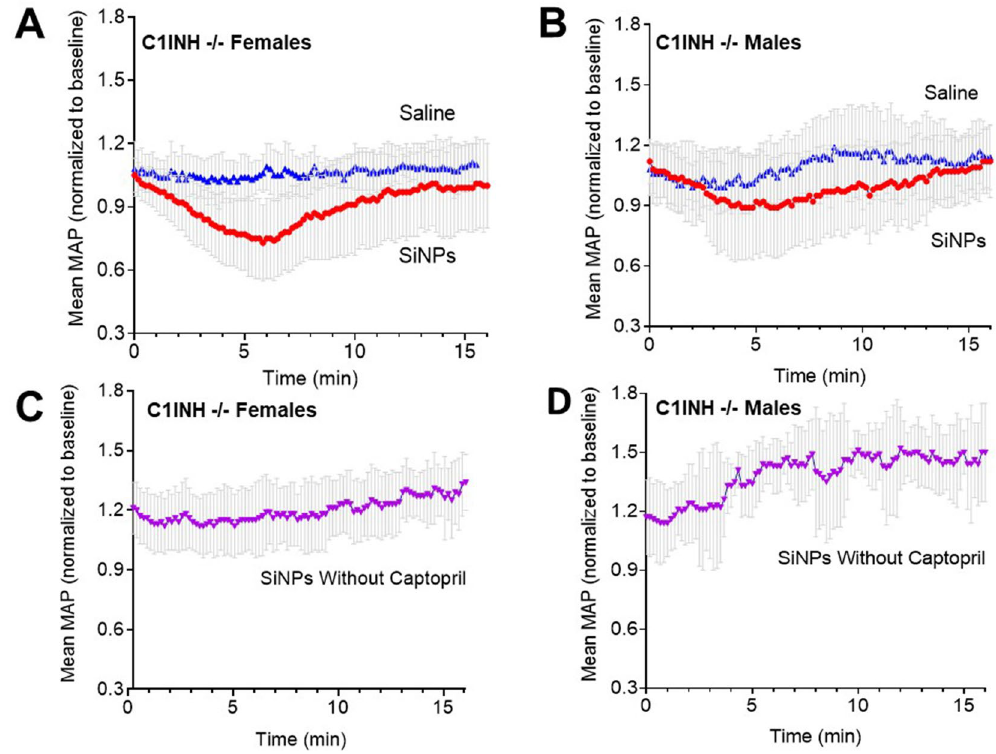
Figure 1. In Vivo stimulation of the contact pathway with SiNPs in serping1−/− mice evokes acute HAE-like attacks in the presence of Captopril. Bolus IV injection of SiNPs (0.25 mg/100 µl) at t = 0 in captopril treated serping1−/− females; n = 18 ( A ) and males; n = 12 ( B ) evoked a rapid and reversible decrease in MAP. When serping1−/− females (n = 9) and males (n = 6) were injected with a single bolus IV injection of saline (vehicle), in the presence of captopril, no change in MAP was reported ( A , B ). Bolus IV injection of SiNPs (0.25 mg/100 µl) in the absence of captopril had no such effect on MAP in serping1−/− females; n = 6 ( C ) or males; n = 3 ( D ). Data points represent mean ± SD of normalized